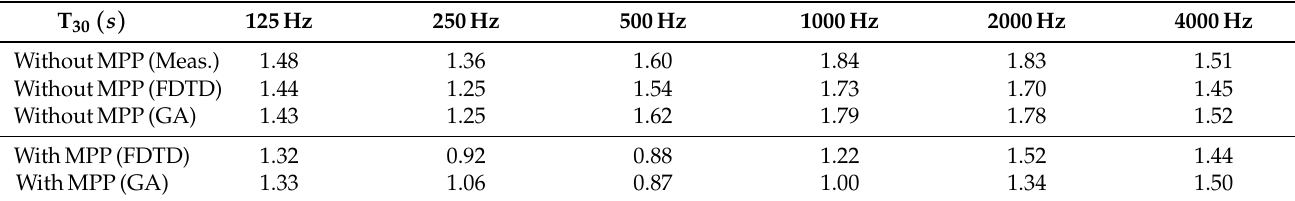
Table 6. Trend in frequency of T 30 mean values corresponding to the results of the measurements (“Meas”), the equivalent values derived from the calibrated FDTD model (“without MPP”) and the variations due to the introduction of MPPs (“with MPP”). The T 30 mean values derived from the corresponding GA simulations are provided as a term of comparison.